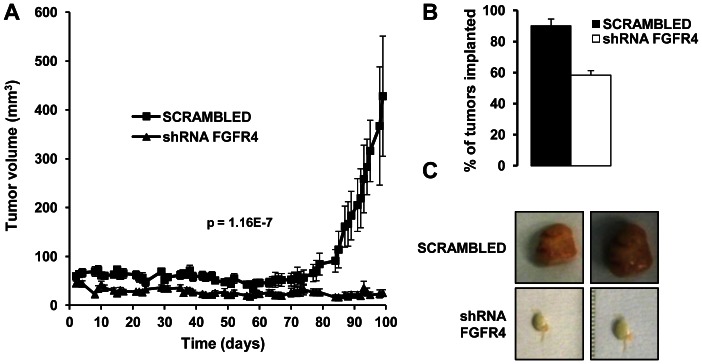
FGFR4-silencing reduces tumor growth in vivo.A. Scrambled and FGFR4-silenced SW48 cells were subcutaneously xenografted in swiss nude mice and the growth of the tumors formed by each cell population was followed. The statistical significance for each time point was determined by unpaired t-test. The comparison of the tumor volumes of the two mouse cohorts was statistically significant. B. Mice were visually and manually inspected to determine the number of tumors implanted. Implanted tumors were as bar graph. C. At day 100, both groups of animals were euthanized, and tumors were dissected and photographed. Dissected tumors representative for the both groups are depicted.